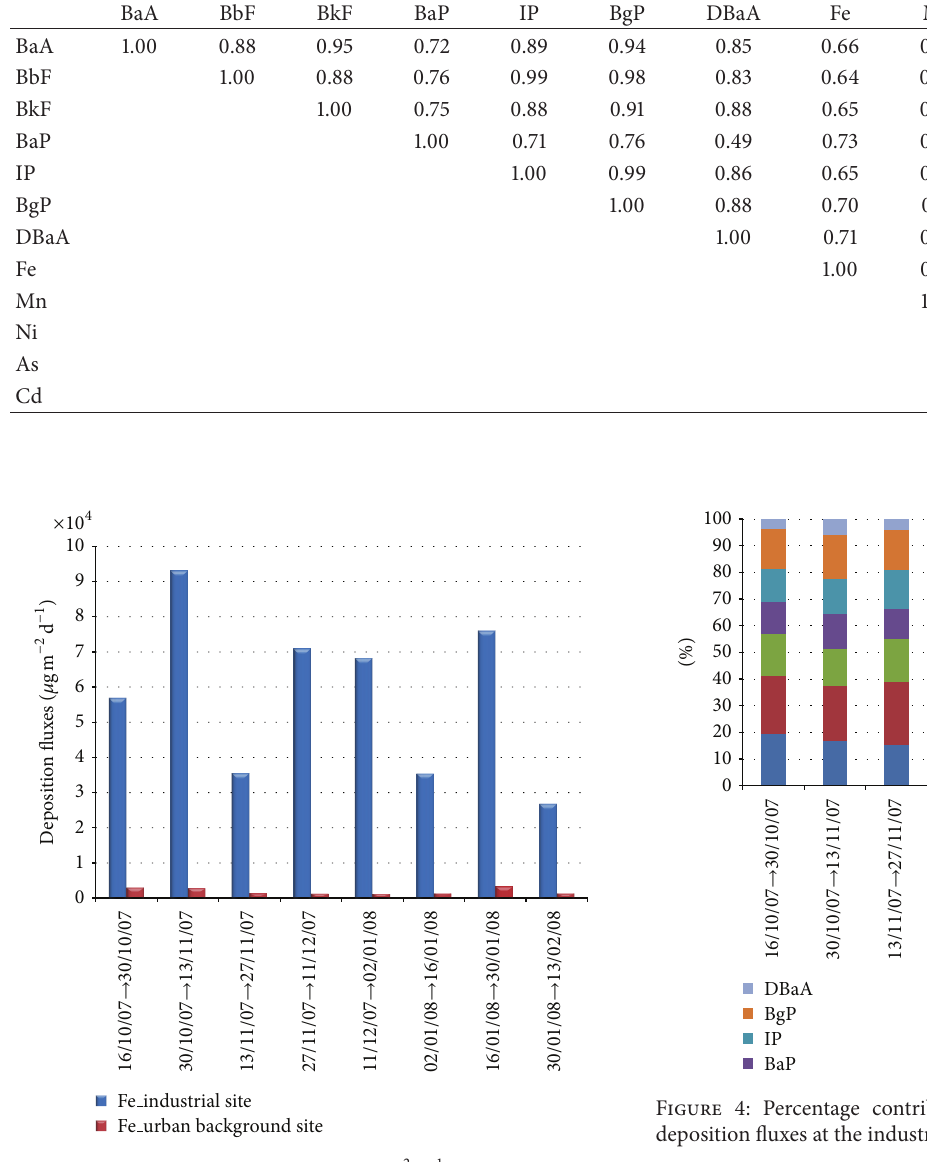
Figure 3: Iron (Fe) deposition fluxes ( 𝜇 gm −2 d −1 ) at two monitored sites.